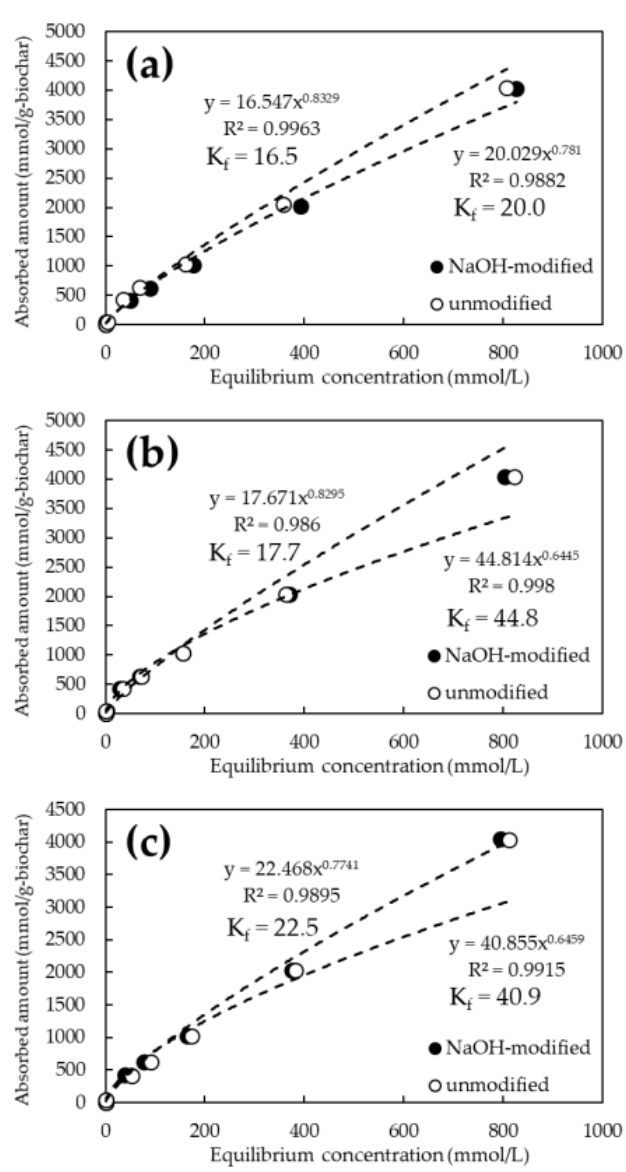
Figure 6. Cd adsorption isotherms for NaOH-modified and unmodified biochars at various pyrolysis temperatures. ( a ) Pyrolysis temperature: 600 °C; ( b ) Pyrolysis temperature: 800 °C; ( c ) Pyrolysis temperature 1200 °C.